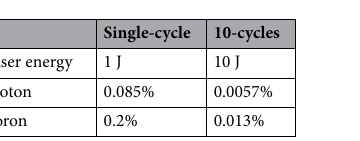
Figure 10. Mass stopping power as function of the energy in a pB (proton–Boron) solid target. In black Electronic mass stopping power and in blue the nuclear mass stopping power. ( a ) In the case of transport of proton in pB. ( b ) In the case of transport of Boron in pB.